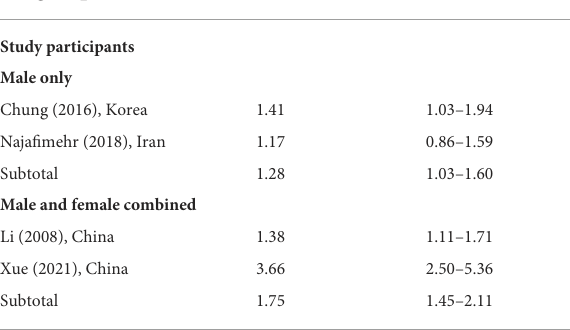
TABLE 4 Subgroup analysis of odds ratio based on whether the participants were male only vs. male and female